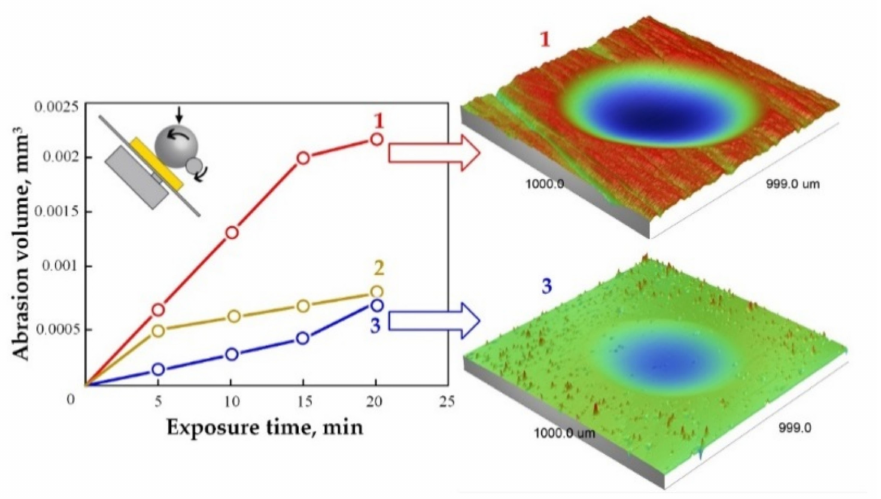
Figure 14. Dependence of abrasion volume on test time for a not-processed cutting plate ( 1 ), for a plate with TiAlN coating ( 2 ) and a plate coated with TiAlN after removal of a 10 µ m-thick defective layer from its surface ( 3